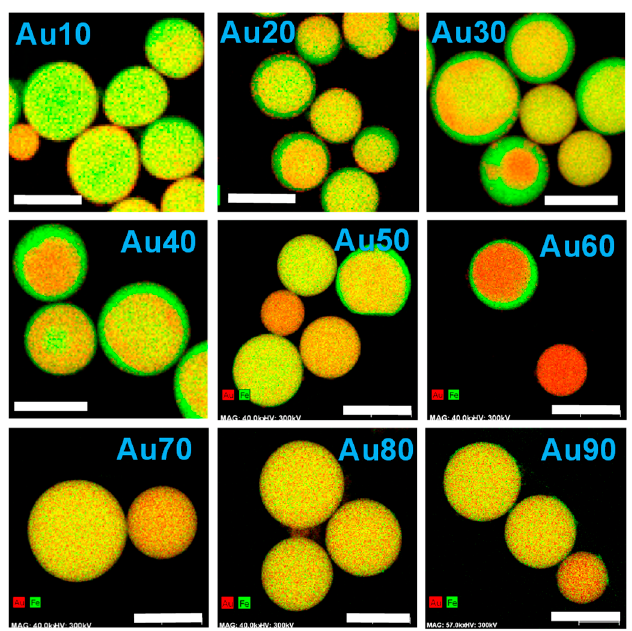
Figure 2. EDS mapping images of particles obtained with different mixing ratios of raw nanoparticle solutions of Au and Fe 2 O 3 . “Au10” indicates an Au 10%: Fe 90% in weight. The red and green colours correspond to the Au and Fe components, respectively. Corresponding HAADF-STEM images are shown in Figure S2 in Supporting Information. All scale bars are 500 nm.